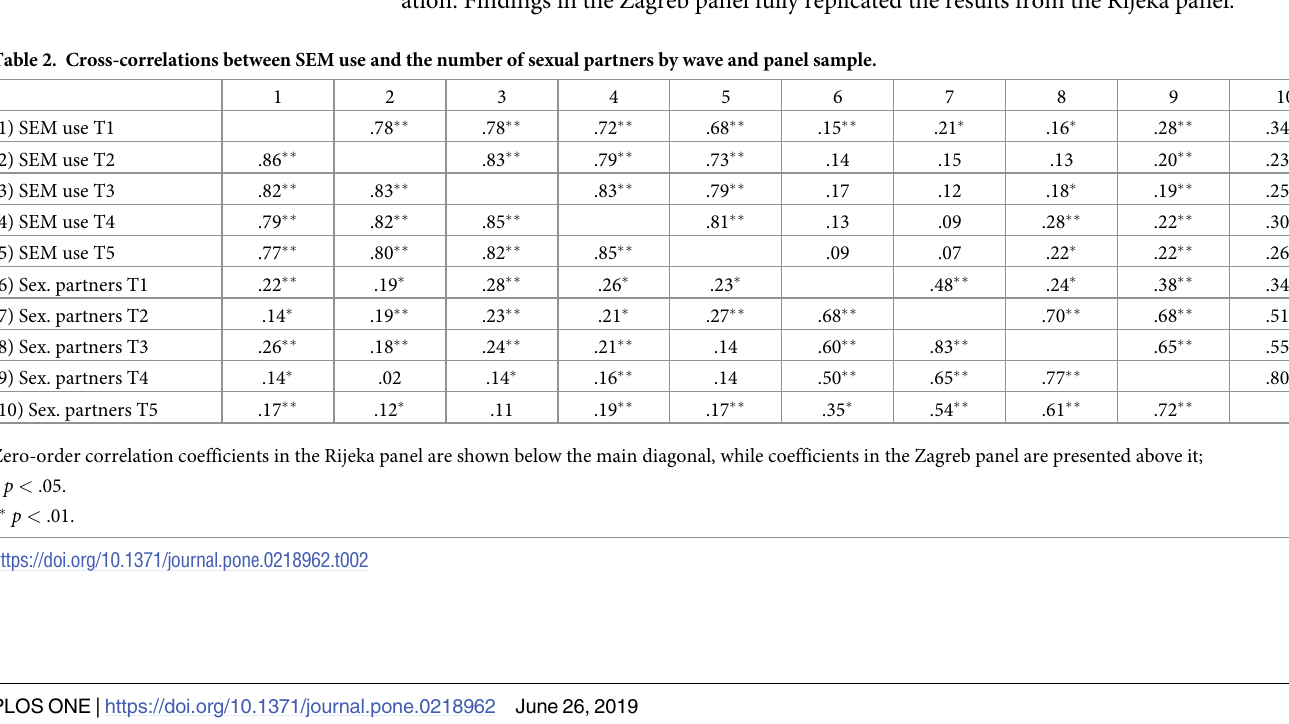
( OR = 1.13, p = .036) than their peers who reported only one partner (Table 4). However, the association ceased to be significant after including the control variables (Model 2).